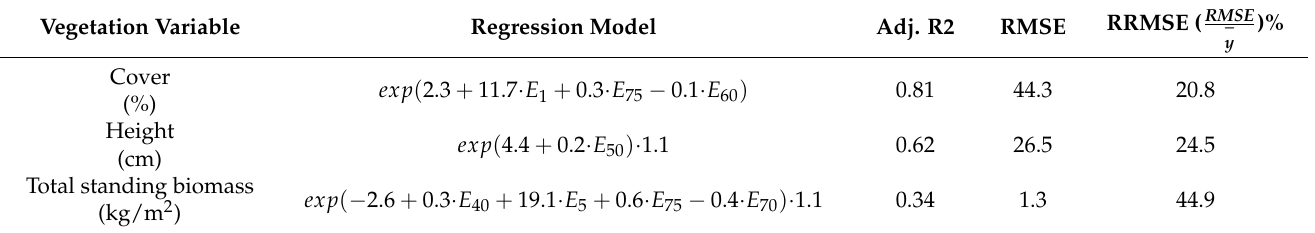
Figure 4. Observed and predicted values of the variables under study using LiDAR and Sentinel-2 metrics. Red line corresponds to diagonal line and blue line correspond to trend line. Table 8. Summary of best regression models and the corresponding statistical metrics (Adjusted R 2 , RMSE and RRMSE) determined for each vegetation variable using LiDAR metrics. The RMSE units are the same as those of the dependent